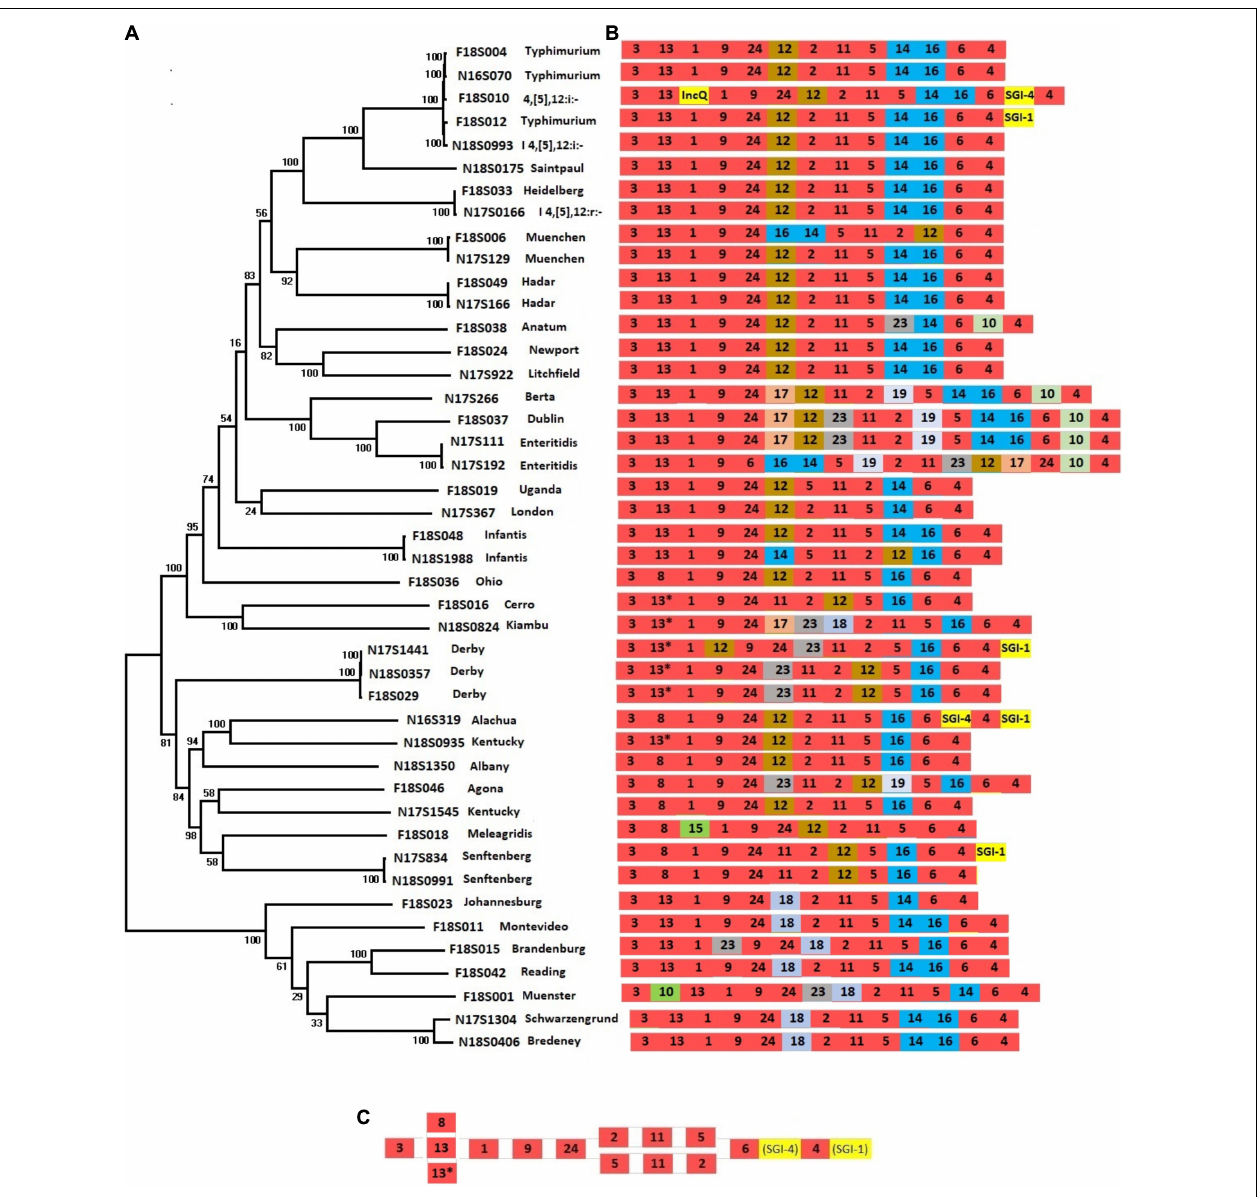
FIGURE 1 | Presence of SPIs in different Salmonella serotypes. (A) A phylogenetic tree was constructed based on chromosomal SNPs of each of the isolates. (B) SPI arrangements are listed with representative sequences of each serotype. Red indicates that SPIs are conserved in all serotypes, yellow indicates insertions of SGIs or plasmids. Other colors represent SPIs whose presence are variable among different serotypes/isolates. (C) The conserved structure across all serotypes is